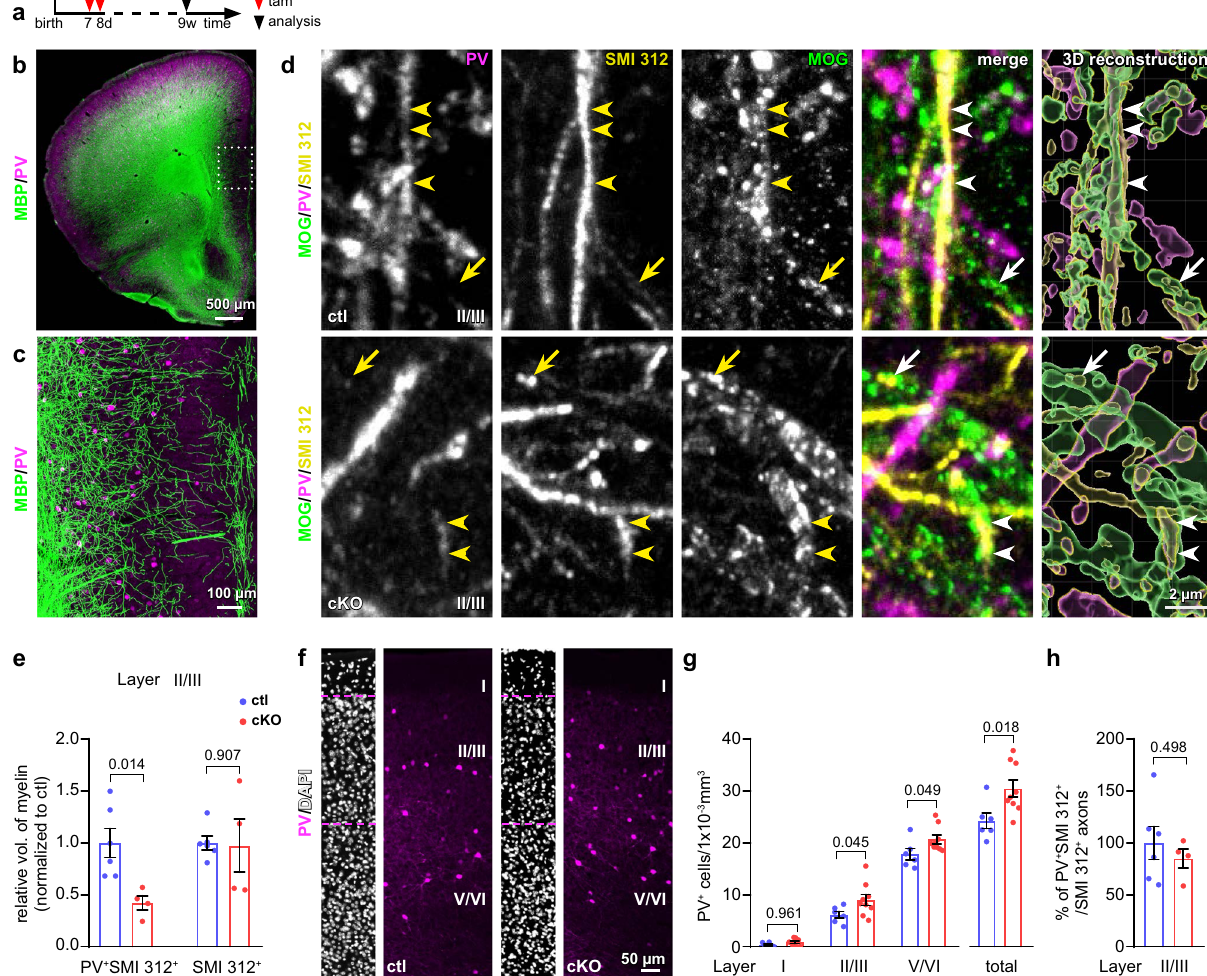
Fig. 2 Reduced myelination and increased cell density of interneurons in OPC-GABA B R cKO mice. a Experimental schedule. b , c Overview of coronal brain slices immunostained for parvalbumin (PV, magenta) and MBP (green). PV + neurons are abundantly myelinated in the mPFC. d Magni fi ed micrographs of myelinated PV axons immunostained for PV (magenta), neuro fi lament (with SMI 312 antibody, yellow) and myelin-oligodendrocyte glycoprotein (MOG, green) in layers II/III (II/III) ctl and cKO. The 3D reconstruction was performed using Imaris. Arrows: myelinated PV - SMI 312 + axons; arrowheads: myelinated PV + SMI 312 + axons. e Relative volume of MOG immunolabel around PV + axons (PV + SMI 312 + ) and total axons (SMI 312 + ) (normalized to ctl) (ctl = 6 mice, cKO = 4 mice, two-sided unpaired t -tests). Immunostaining ( f ) and quanti fi cation ( g ) of PV + interneurons in different layers of mPFC at the age of 9 weeks (ctl = 6 mice, cKO = 9 mice; two-way Anova, Sidak ’ s multiple comparison for different layers; two-sided unpaired t -tests for total). h Ratio of PV + interneuron axons to all axons. (ctl = 6 mice, cKO = 4 mice, two-sided unpaired t -test). Data are shown as mean ± SEM in e , g and h . Source data are provided as a Source Data fi